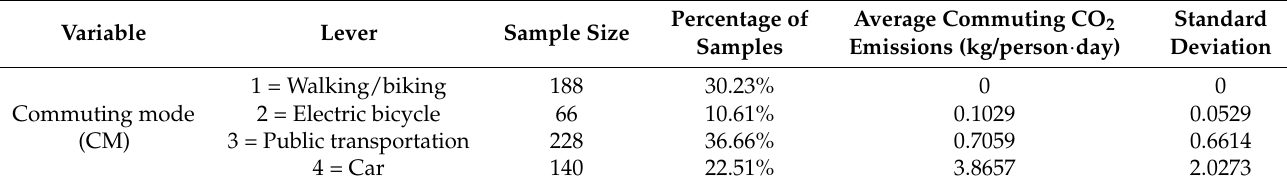
Table 3. Share of each transportation mode and average CO 2